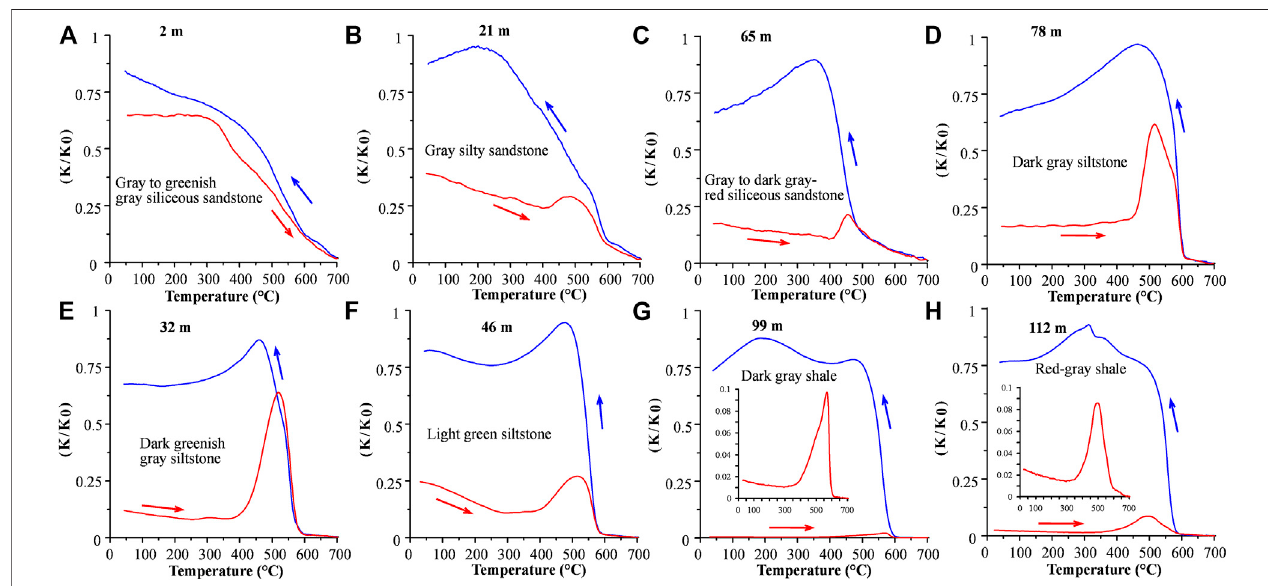
FIGURE5| Representativetemperature-dependentsusceptibility curvesfromselectedsamplesatvarioushorizonsofthePalpasection. Thesampleswithalow χ value are shown in (A – D) and a high χ value in (E – H) . Note: Heating and cooling cycles are indicated by red and blue lines, respectively.